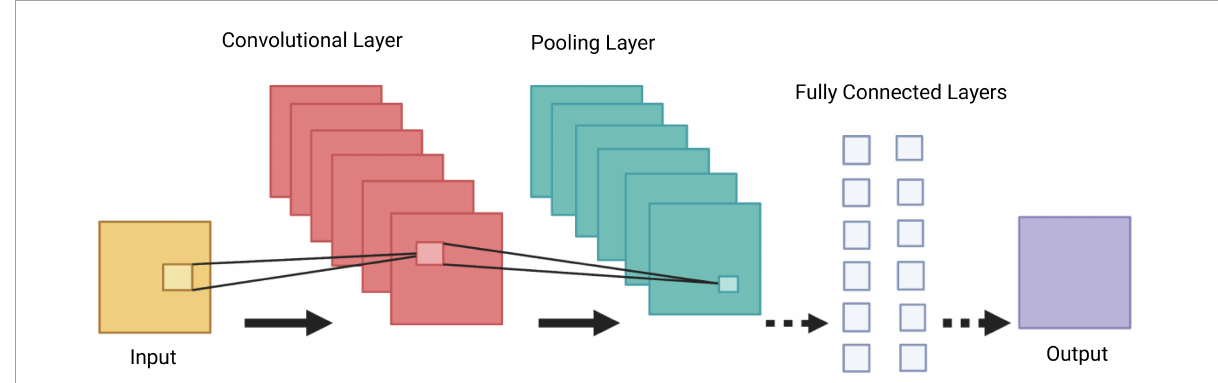
FIGURE3 Demonstration of a Convolutional Neural Network (CNN) architecture. A CNN is composed of several blocks which include convolutional layers, pooling layers, and fully connected